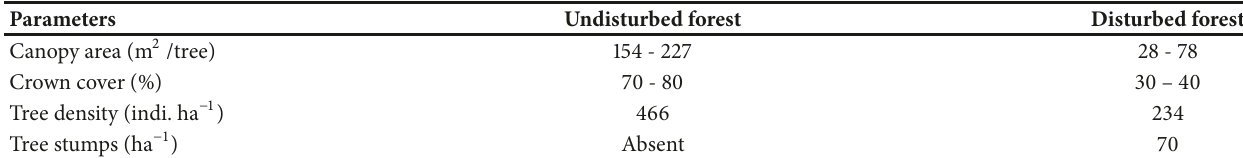
Table 1: Parameters used to classify the studied forest as undisturbed and disturbed.